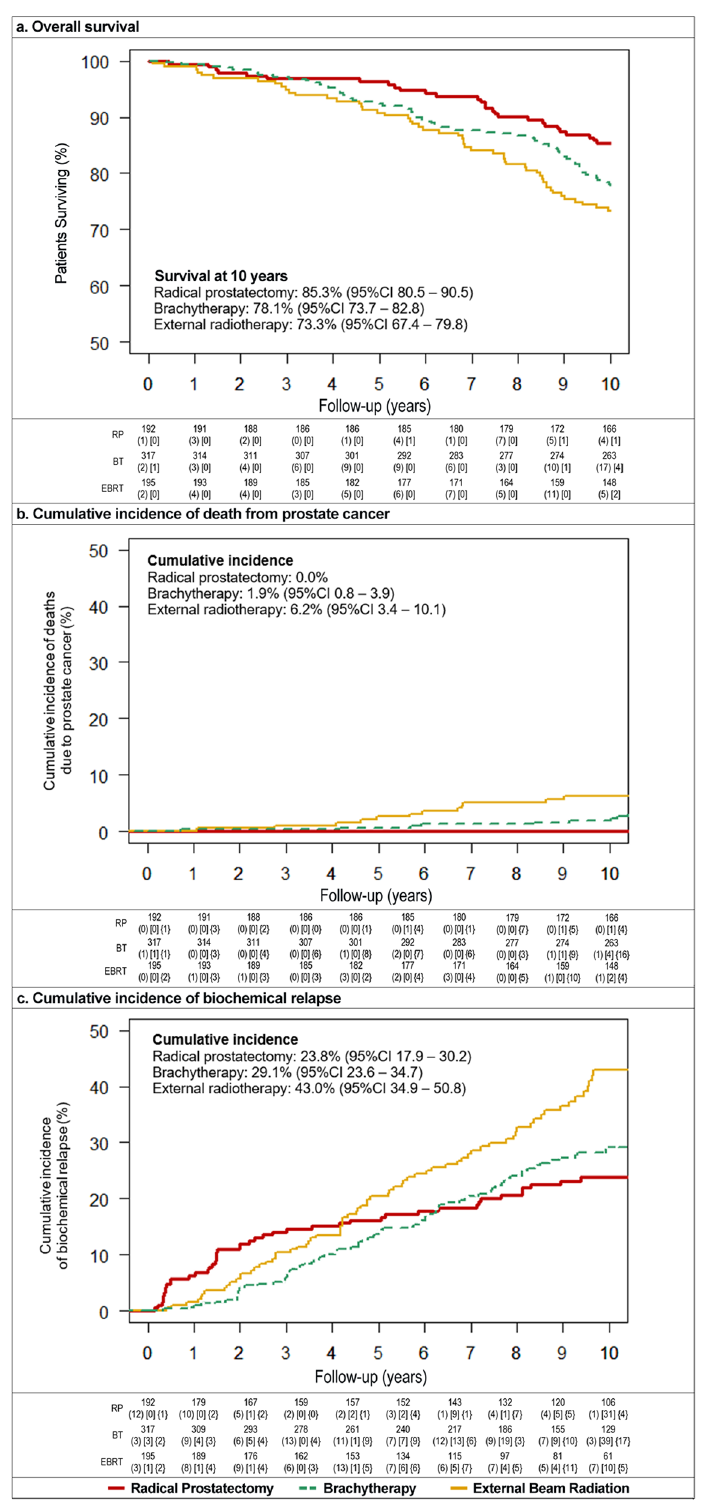
Figure 1. Kaplan–Meier plots among radical prostatectomy (red line), brachytherapy (green line) and external radiotherapy (yellow line). BT Brachytherapy, EBRT External Beam Radiotherapy, RP Radical Prostatectomy. Numbers represent: patients at the beginning of the year; (patients with the event of interest); [patients lost to follow-up]; and {patients at competing